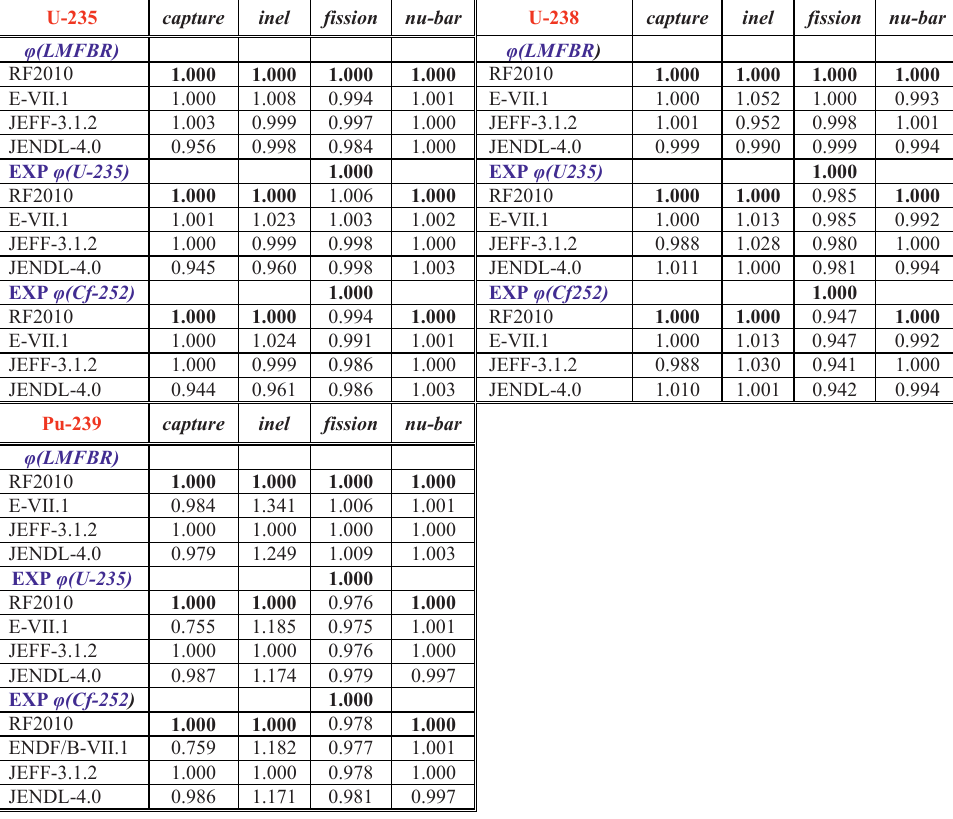
Table 2. The comparison of the average cross sections for fission nuclide.